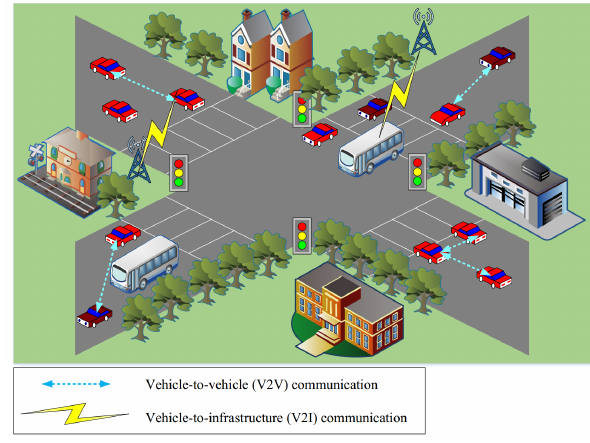
Figure 1. Intelligent transportation system (ITS) in smart